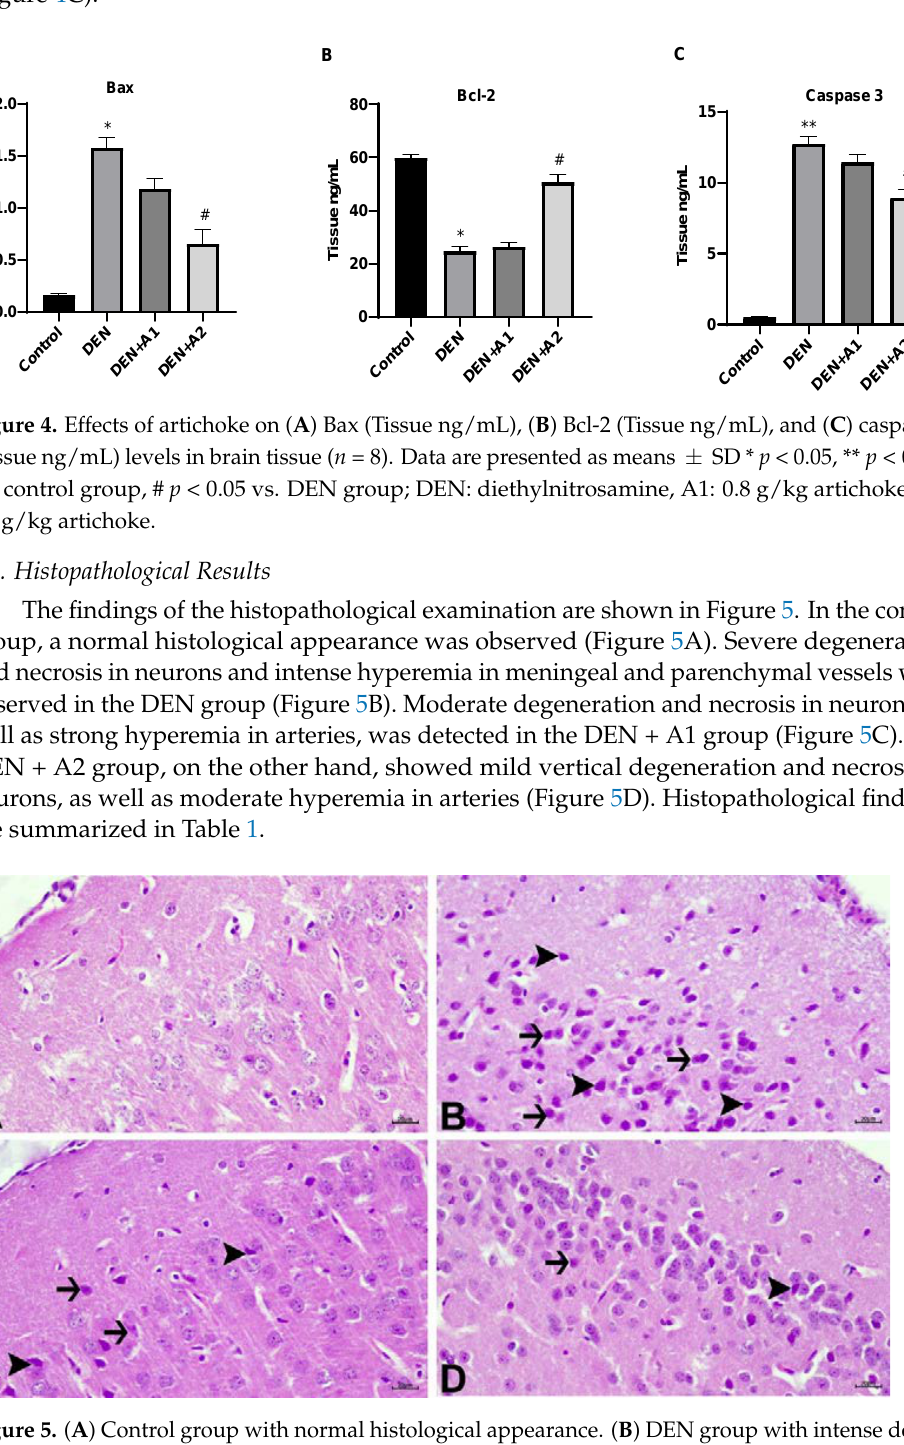
Figure 5. ( A ) Control group with normal histological appearance. ( B ) DEN group with intense de- generation (arrows) and necrosis (arrowheads) of neurons. ( C ) DEN + A1 with moderate degeneration (arrows) and necrosis (arrowheads) in neurons. ( D ) DEN+ A2 with mild degeneration (arrows) and necrosis (arrowheads) in neurons. DEN: diethylnitrosamine, A1: 0.8 g/kg artichoke, A2: 1.6 g/kg artichoke; H&E, Bar: 20 µm.